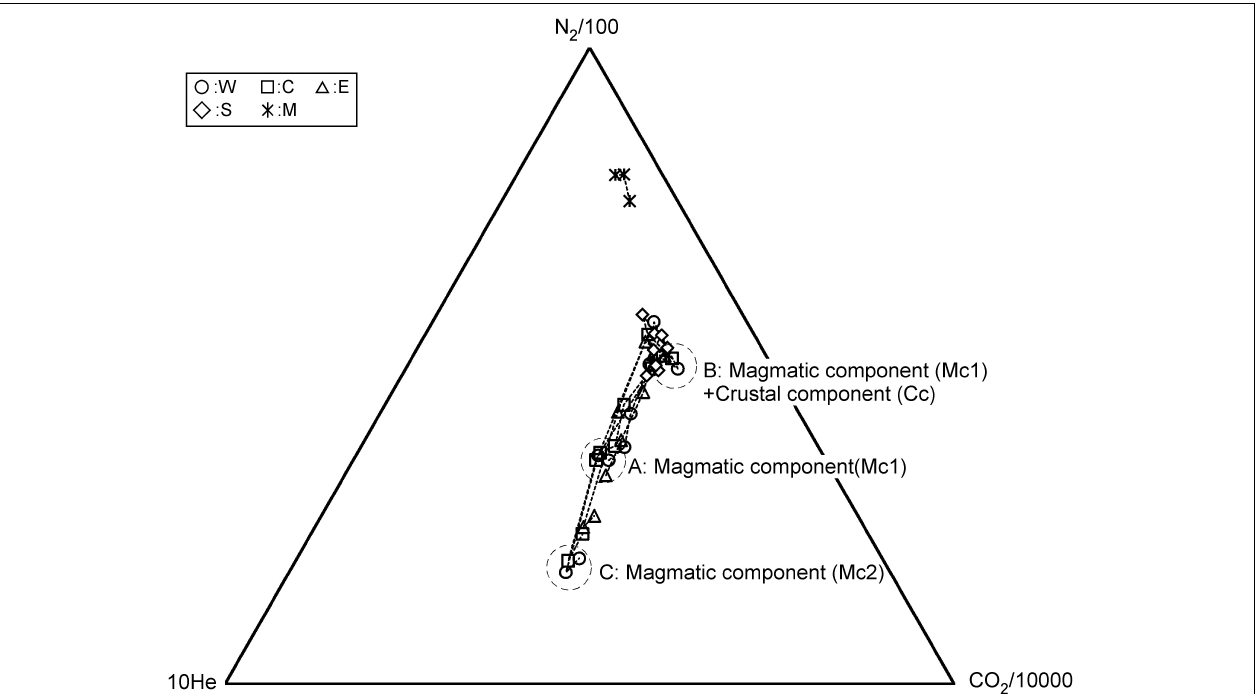
FIGURE 7 | He-N 2 -CO 2 ternary molar composition of fumarolic gas. The position of A, B, and C indicate the composition in July 2014, November 2017 and August 2018,